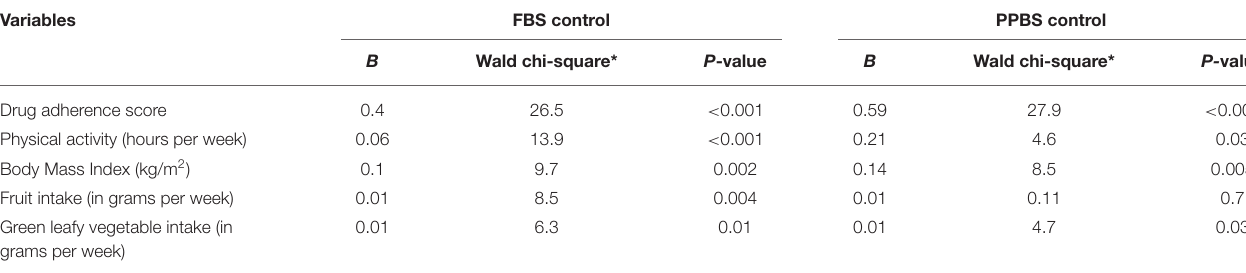
TABLE 5 | Factors associated with glycemic control.